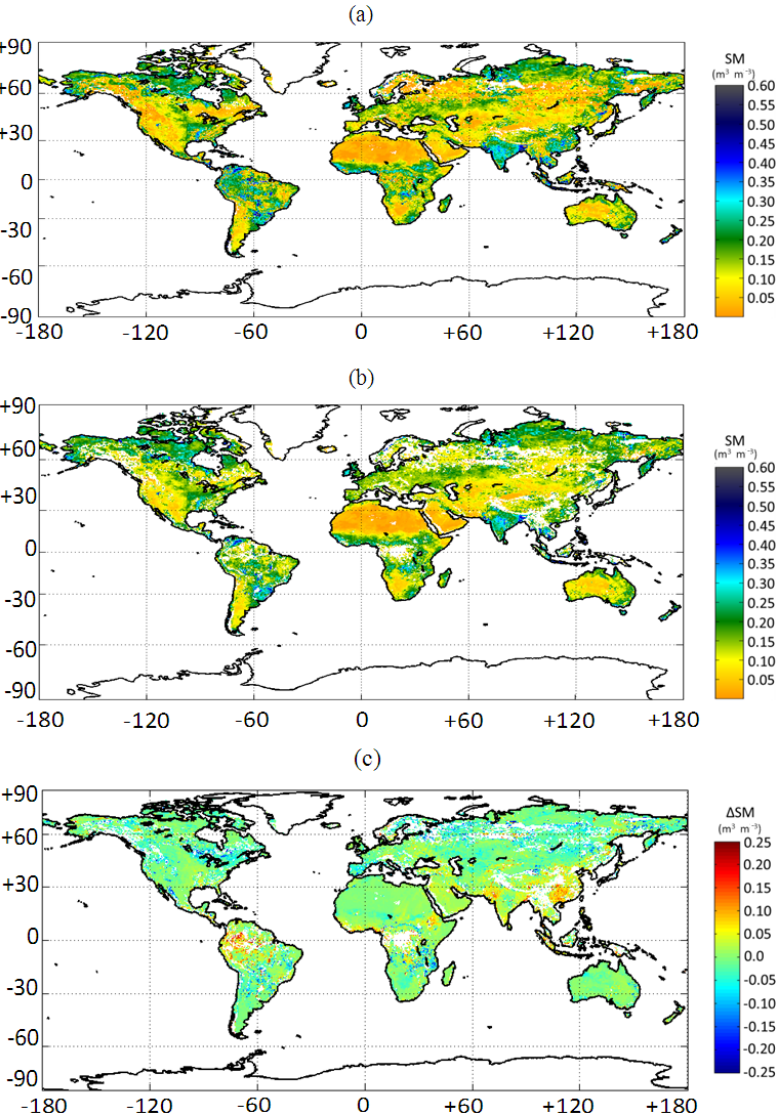
Figure 10. Mean soil moisture map over 2011–2015 for ascending orbits from CATDS L3SM MO (a) , DPGS L2SM SO (b) and the difference (MO–SO) map between L3SM MO and L2SM SO (c)